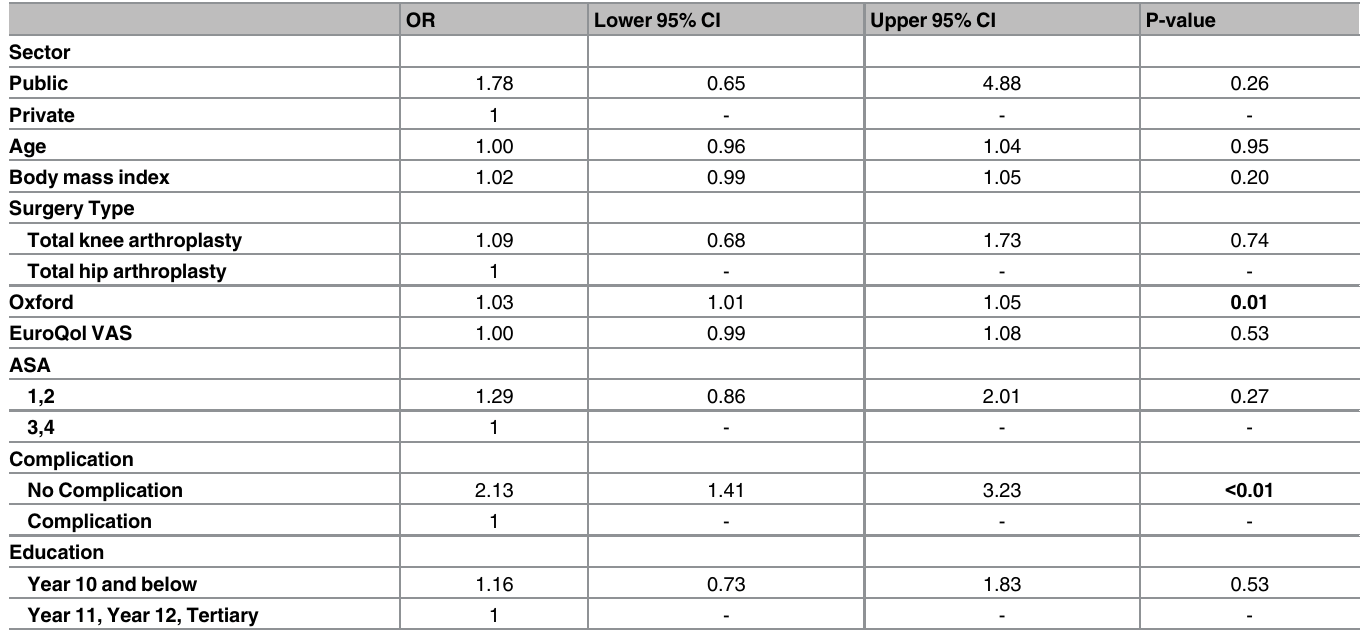
Table 4. Multivariate analyses for the prediction of high-level satisfaction ( (cid:1) 90% or <